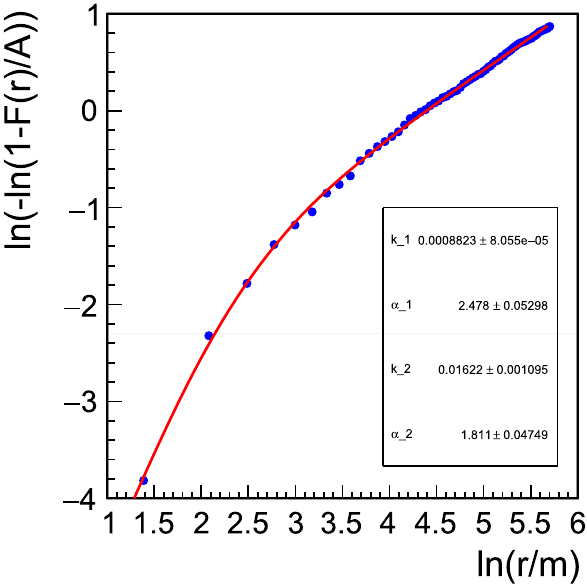
Fig. 4 The blue points represent the binned cumulative function of the electromagnetic energy distribution at the ground of the event shown in Fig. 1, assuming A 1 = S em . The red line is the best fit to these data points using the parametrization defined in Eq.